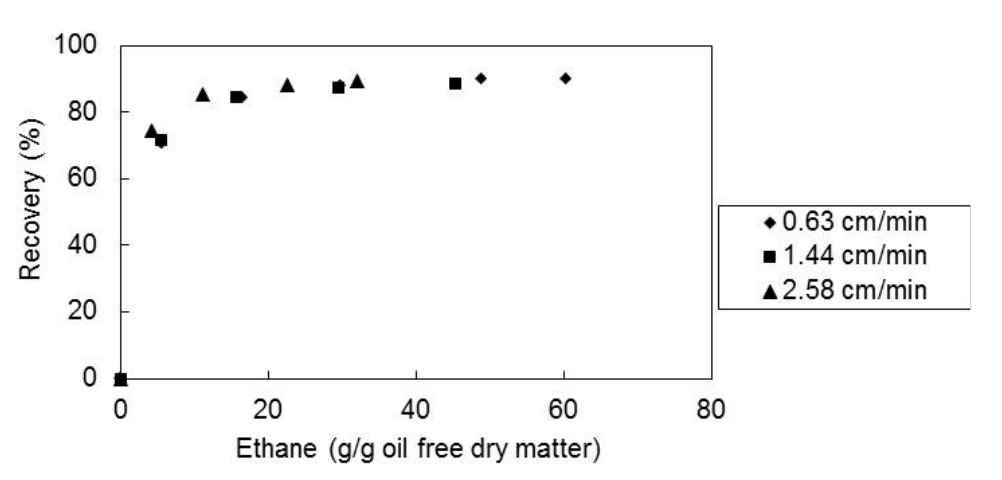
Figure 5. Recovery of all- E -lycopene from sample M2 as a function of solvent amount, at 60 °C, 300 bar and matrix particle size of 0.36 mm for the several solvent superficial